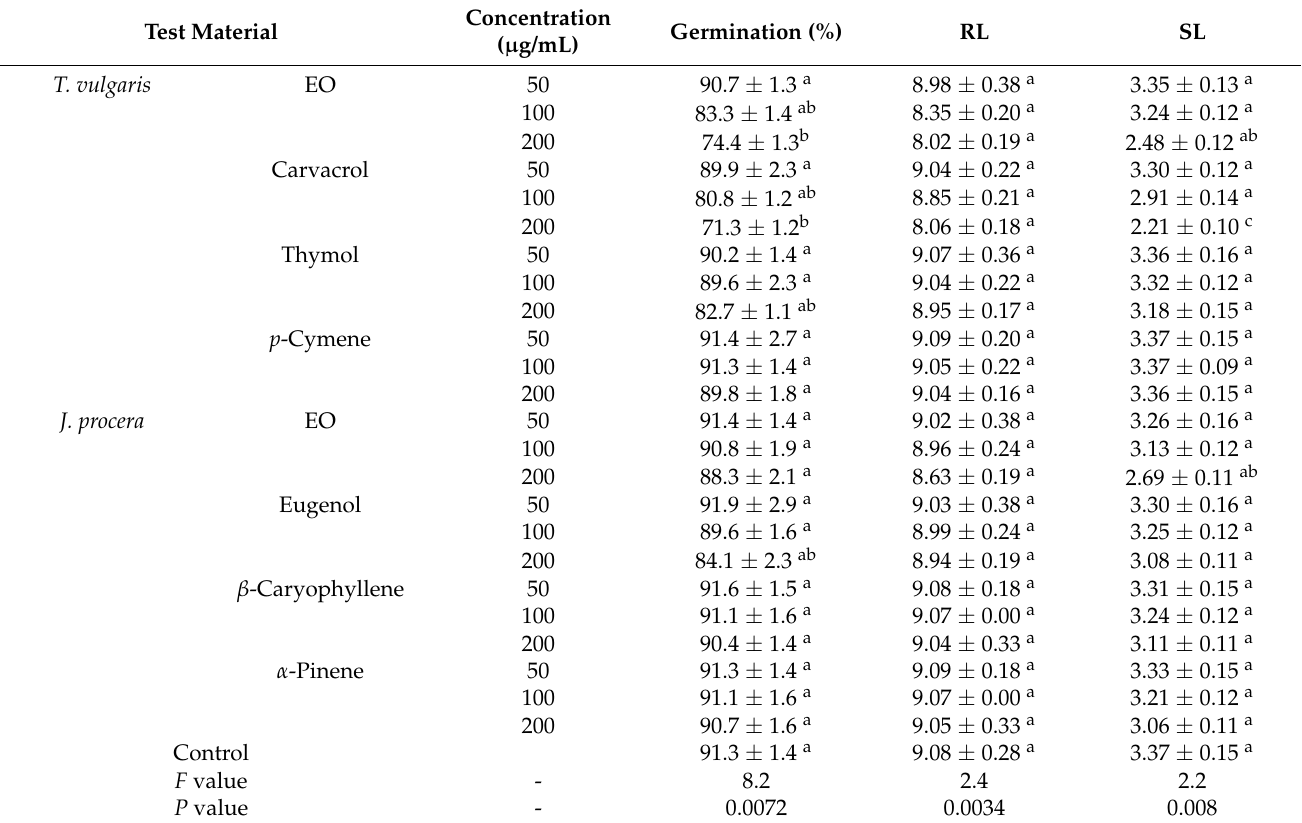
Table 8. * Phytotoxic activity of the tested plant oils and their fractions against wheat plants. Test